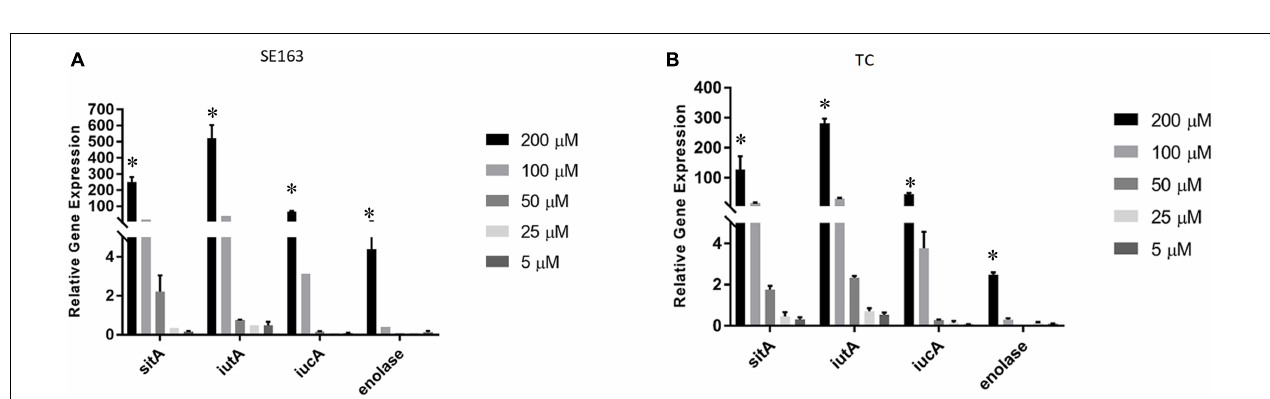
FIGURE 2 | Iron acquisition and other virulence genes of S. enterica were upregulated in iron-depleted conditions compared to iron-rich conditions. qRT-PCR was performed using SYBR green assays on sitA , iutA , and enolase to examine gene expression levels in LBIR (A,C) and LBID (B,D) conditions. The data in the figure depicts the transcription level of either strain SE163 (A,B) or transconjugant (TC) (C,D) grown at 0, 2, 4, or 18 h. LBIR was supplemented with 100 µ M ferric chloride and LBID was supplemented with 200 µ M bipyridyl. The 0 h time point, where strains were grown in LB, served as the baseline expression level of these four genes. Two biological replicates and three technical replicates were used for each sample ( ± SD). Gene expression was normalized by gmk and adk reference genes. Student’s t -test was performed between 0 h vs. 2 h; 0 h vs. 4 h; 0 h vs. 18 h with data being considered significant when p < 0.05. Although increased expression of sitA , iutA , and enolase were noted between the groups compared (0, 2, 4, and 18 h) in iron depleted condition for both SE163 and TC strains; these data were statistically non-significant.